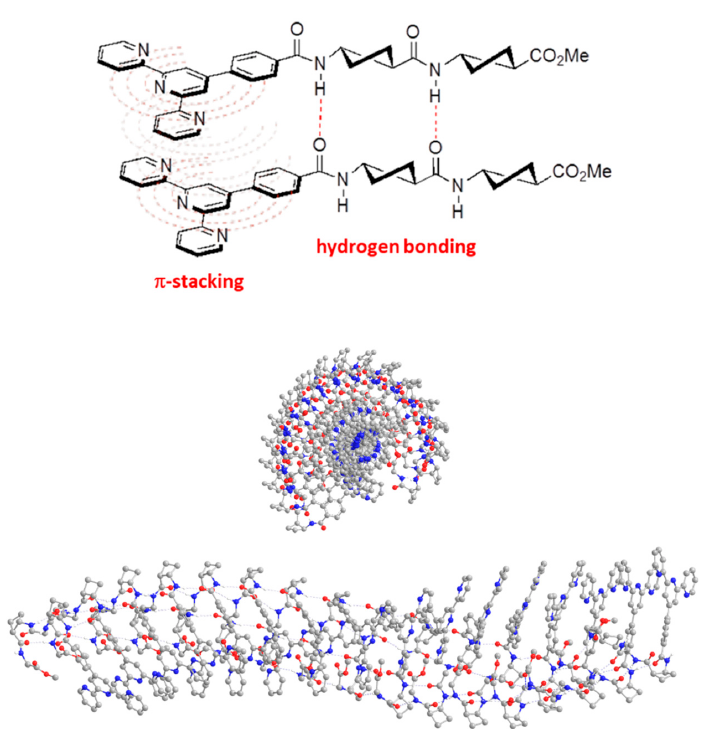
Figure 21. Top : Schematic representation of head-to-head arrangement of a dimer of conjugate 30 . π – π and H-bonding interactions are highlighted in red. Bottom : Top and side view for the predicted structure of a dodecameric aggregate of 31 . Non-polar H atoms were omitted for clarity. Adapted with permission of Elsevier